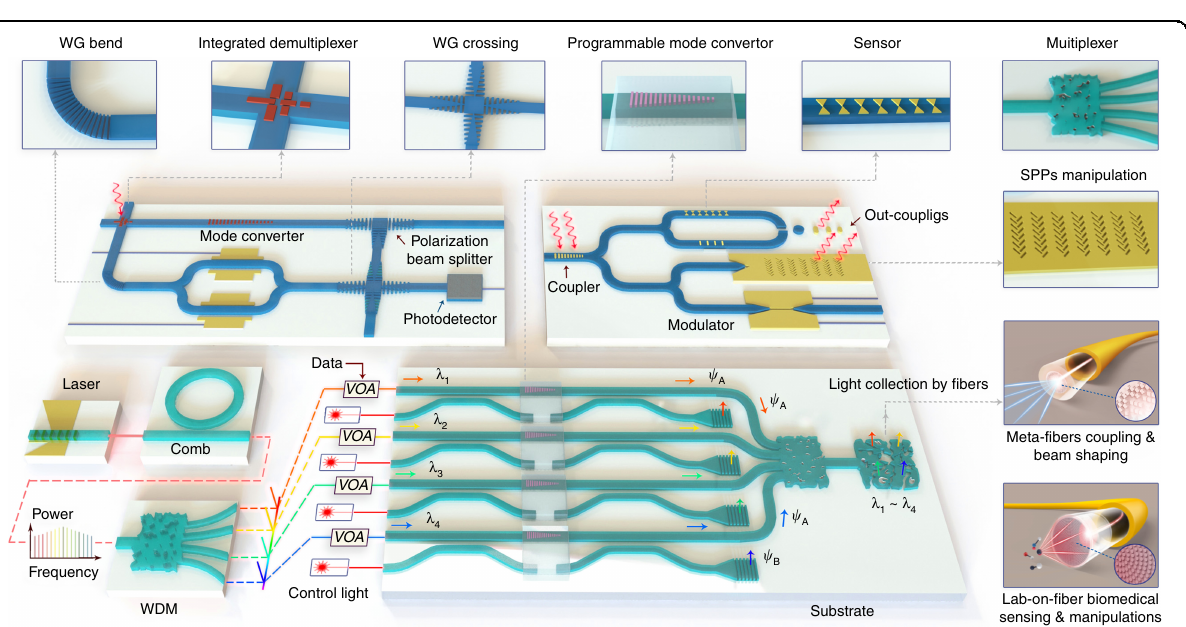
Fig. 13 Outlook on photonic integrated “ meta-circuits ” . Diverse meta-waveguide-based photonic devices can be competitive substitutes for conventional integrated optical scenarios with compact footprint, enhanced ef fi ciency and multifunctionality. A laser-pumped microring frequency comb is distributed to cascaded wavelength division multiplexers (WDM) enabled by inverse-designed metamaterial waveguides (WG). Data can be encoded by variable optical attenuators (VOA) and fed to programmable mode convertors, which can be assembled into integrated photonic networks to perform analog computing of matrix-vector multiplication (MVM) for parallel convolutional processings 177,523 . The recon fi gurable mode convertor can convert mode Ψ A to Ψ B ( Ψ is TE or TM) with various distinguishable levels or to different spatial mode channels in a multimode waveguide 541 . The optical data are then collected via meta-couplers and meta- fi bers with high ef fi ciency and fi delity for further processing. Meta- waveguides can also facilitate on-chip optical signal processing, communications, display and sensing applications (shown as insets). Plasmonic meta-waveguides may shrink device footprint towards higher integration density. Meta- fi bers can also fi nd massive interconnects, signal shaping, biomedical sensing and micro-manipulation applications 232,235 . Device schematics are inspired from previous literatures 12,177,194,235,523,541 – 543